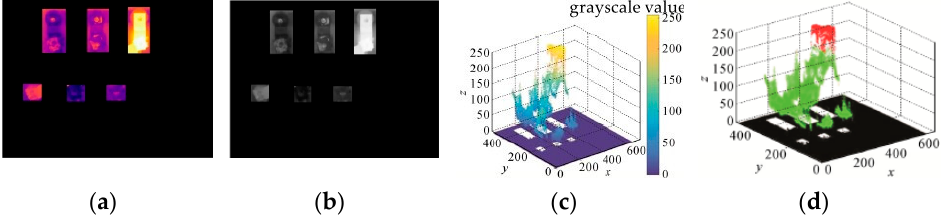
Figure 10. Clustering result of Mean-Shift algorithm: ( a ) detecting results of Faster RCNN net- work; ( b ) grayscale image; ( c ) three-dimensional visualization result of the pixel gray information; ( d ) clustering